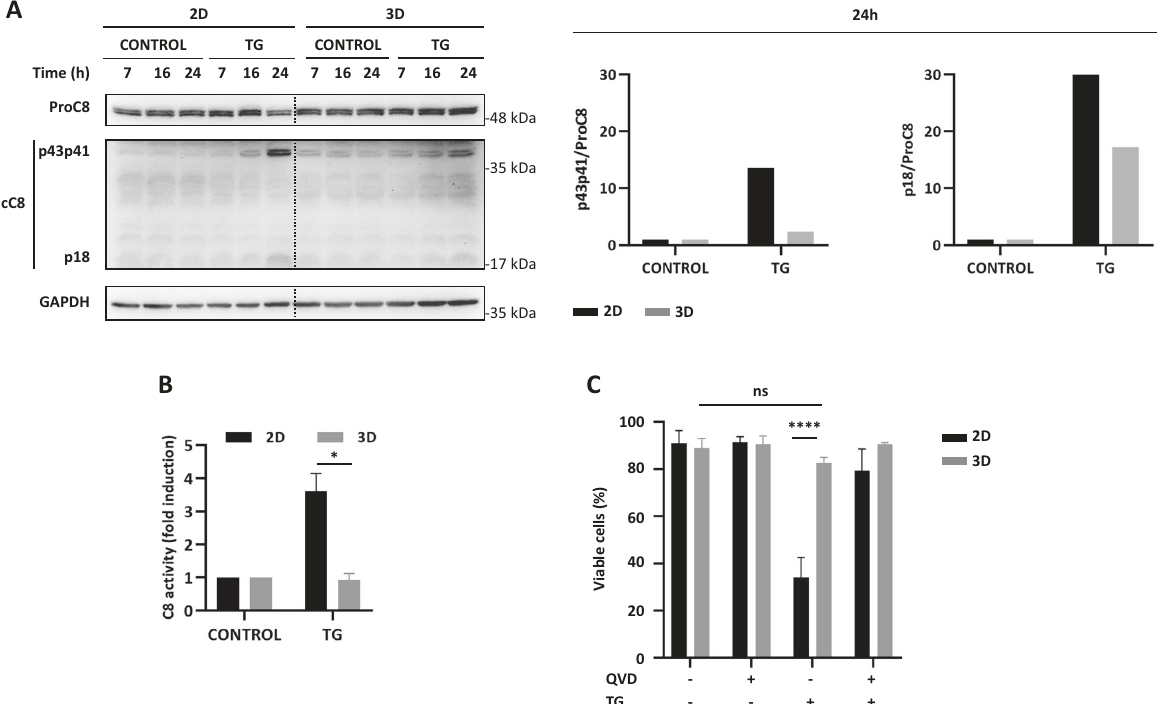
Fig. 6 Delayed activation of apoptosis in multicellular tumor spheroids upon ER stress. A Cultures of HCT116 cells growing in 2D or as spheroids (10-days) were treated with TG (100 nM) for the indicated times. Caspase-8 processing was determined in whole-cell extracts by western blotting. Caspase-8 processing at 24 h of TG treatment was quanti fi ed using GAPDH as protein-loading control with Image Lab TM 6.0 software and graphed relative to 2D- or 3D-untreated controls. Blots are representative of three independent experiments. B 2D or 3D cultures of HCT116 cells were treated with or without TG (100 nM) for 24 h and caspase-8 activity determined by an enzymatic speci fi c assay as described in “ Material and methods ” and graphed relative to 2D- or 3D-untreated conditions (* p ≤ 0.05. Multiple t -test. Holm – Sidak method). C 2D or 3D cultures of HCT116 cells were treated with or without TG (100 nM) in the presence or absence of pan-caspase inhibitor Q-VD-OPh (20 μ M) for 3 days. Cell viability was analyzed after staining with Annexin V-FITC and PI by fl ow cytometry (ns = not statistically signi fi cant; **** p ≤ 0.0001; two-way ANOVA. Tukey ’ s multiple comparisons test).